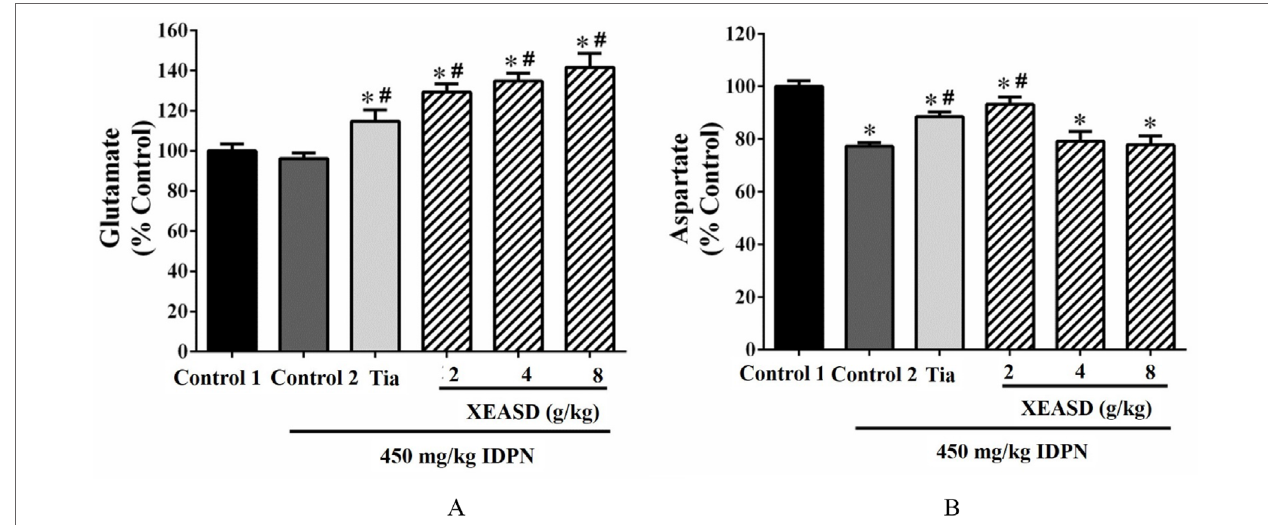
FIGURE 3 | Effects of XEASD treatment on glutamate and aspartate levels in brain tissue of IDPN-induced TS mice. (A) Biochemical assay of glutamate levels was performed as described in Materials and Methods. (B) Levels of aspartate in brain tissues were measured as described in Materials and Methods. Control 1 represents normal control mice; control 2 represents IDPN-challenged control mice. Data are expressed as the percentage of non-challenged control 1 values. * P < 0.05, significantly different from the control 1; # P < 0.05, significantly different from the IDPN control 2. The value of the glutamate levels of control 1 (mean ± S.E.M.) and aspartate level of control 1 (mean ± S.E.M.) were 2953 ± 440 (nmol/mg protein) and 0.73 ± 0.06 (nmol/mg protein), respectively.